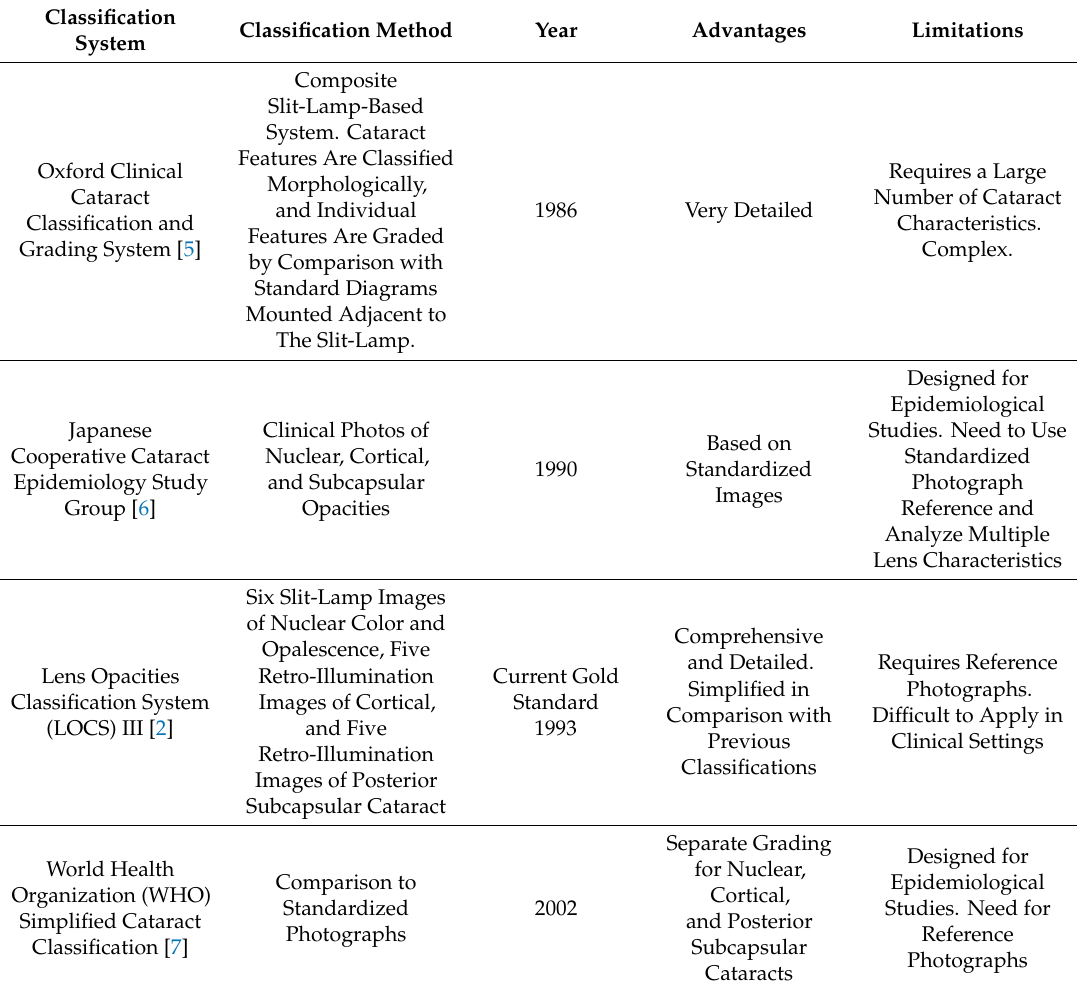
Table 1. Current cataract classification